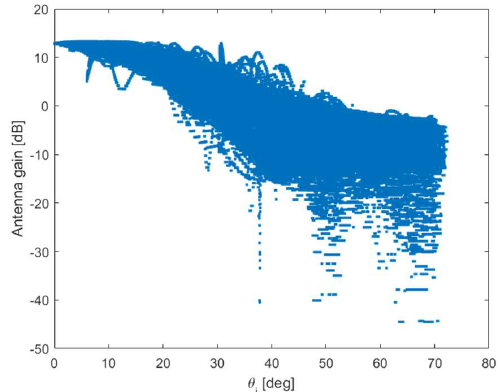
Figure 4. Antenna pattern as a function of the incidence angle.